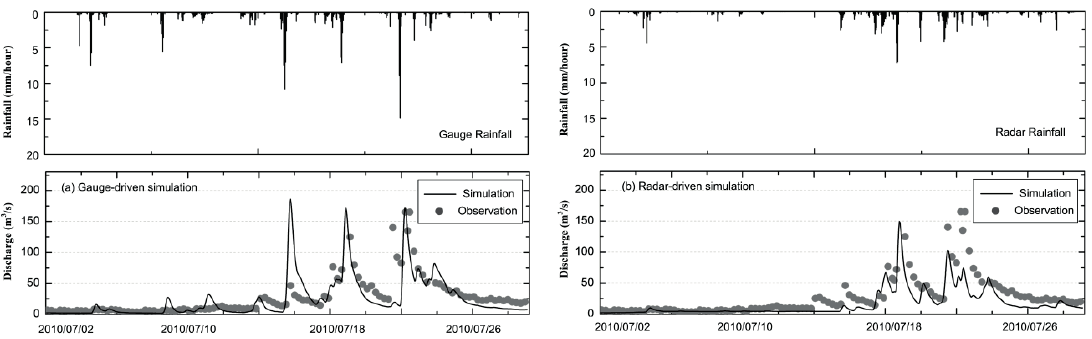
Fig. 6 Comparison of simulation by different rainfall inputs at Yanduhe basin in 2010